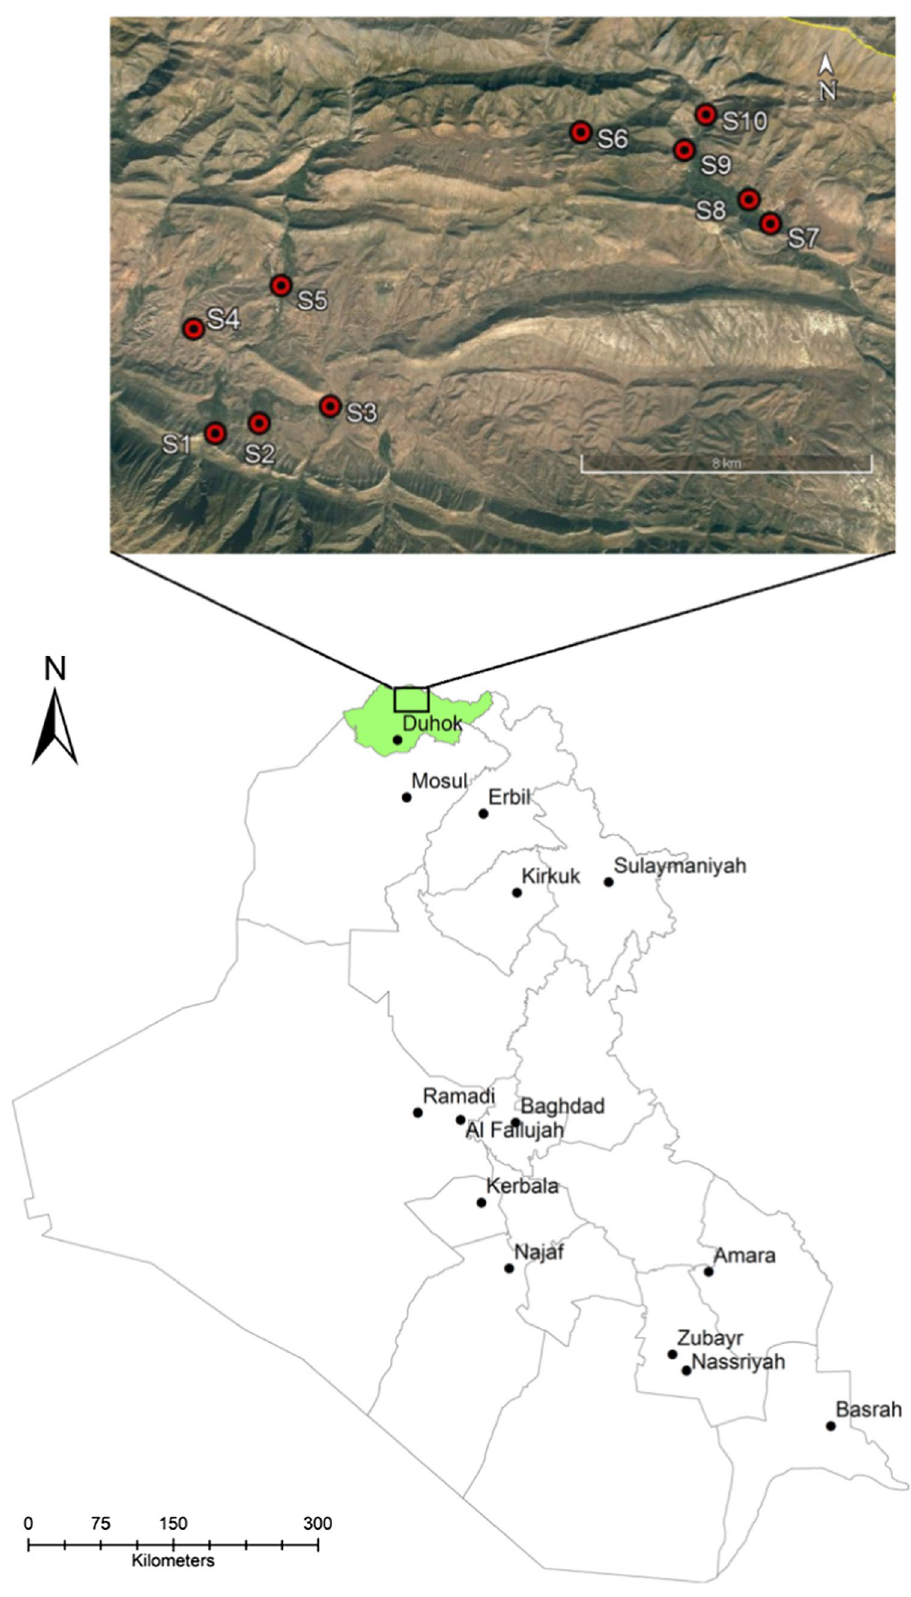
Fig. 1 Map of Iraq with a satellite image of the study area illustrating the sampling